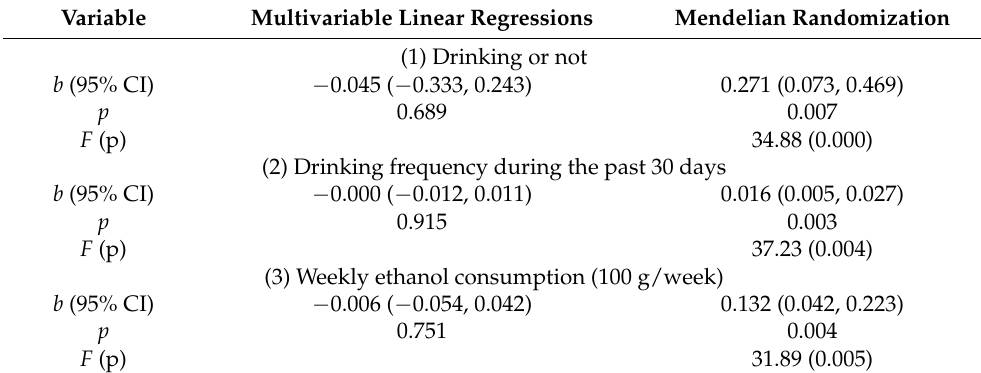
Table 2. Effects of alcohol consumption on MCI-OLS and 2SLS estimation